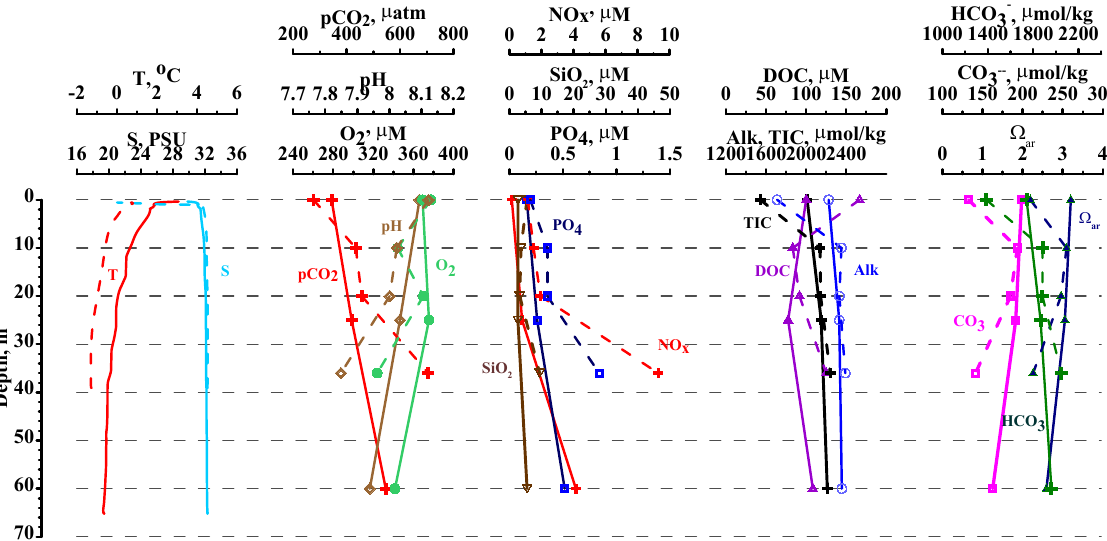
Figure 4. Vertical distribution of physical and chemical parameters at stations TJ1 near the glacier (dotted line) and TJ3 in the middle of the fjord (solid line), sampled on 17/06/2015.